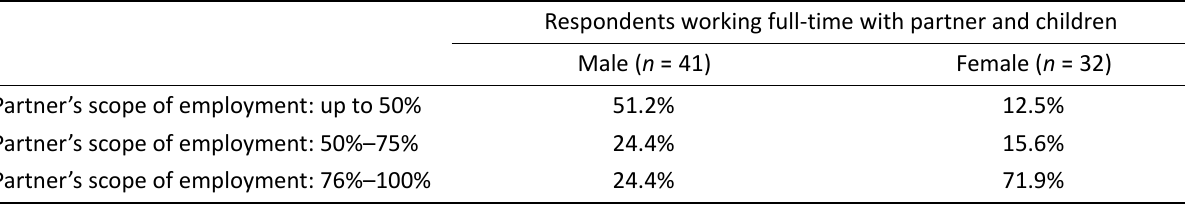
Table 6. Relationship between the gender and scope of employment of the